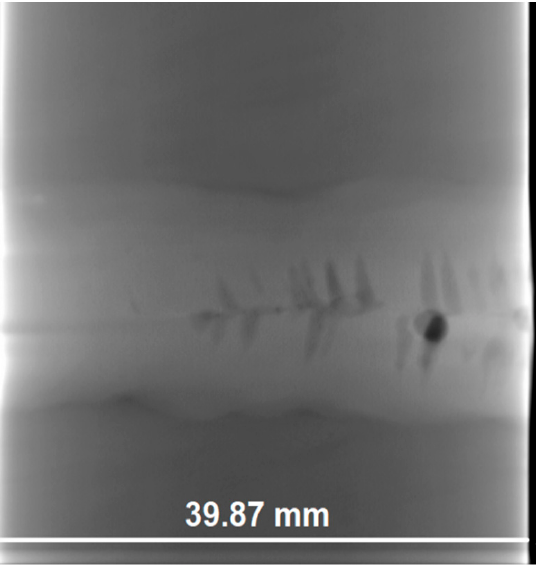
Figure 2. Defects evaluation for specimens of type-NC-2 joints: ( a ) specimen 766-FM-2; ( b ) specimen 766-FM-3 and ( c ) specimen 766-FM-4.